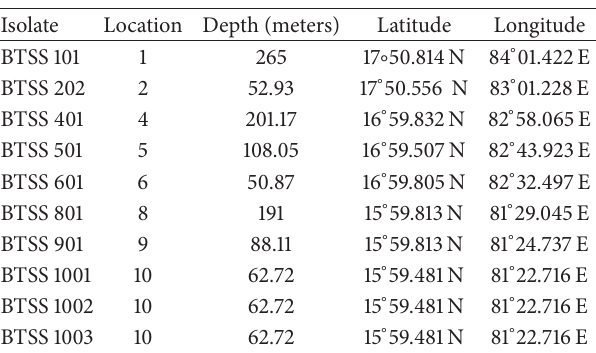
Table 1: Sampling